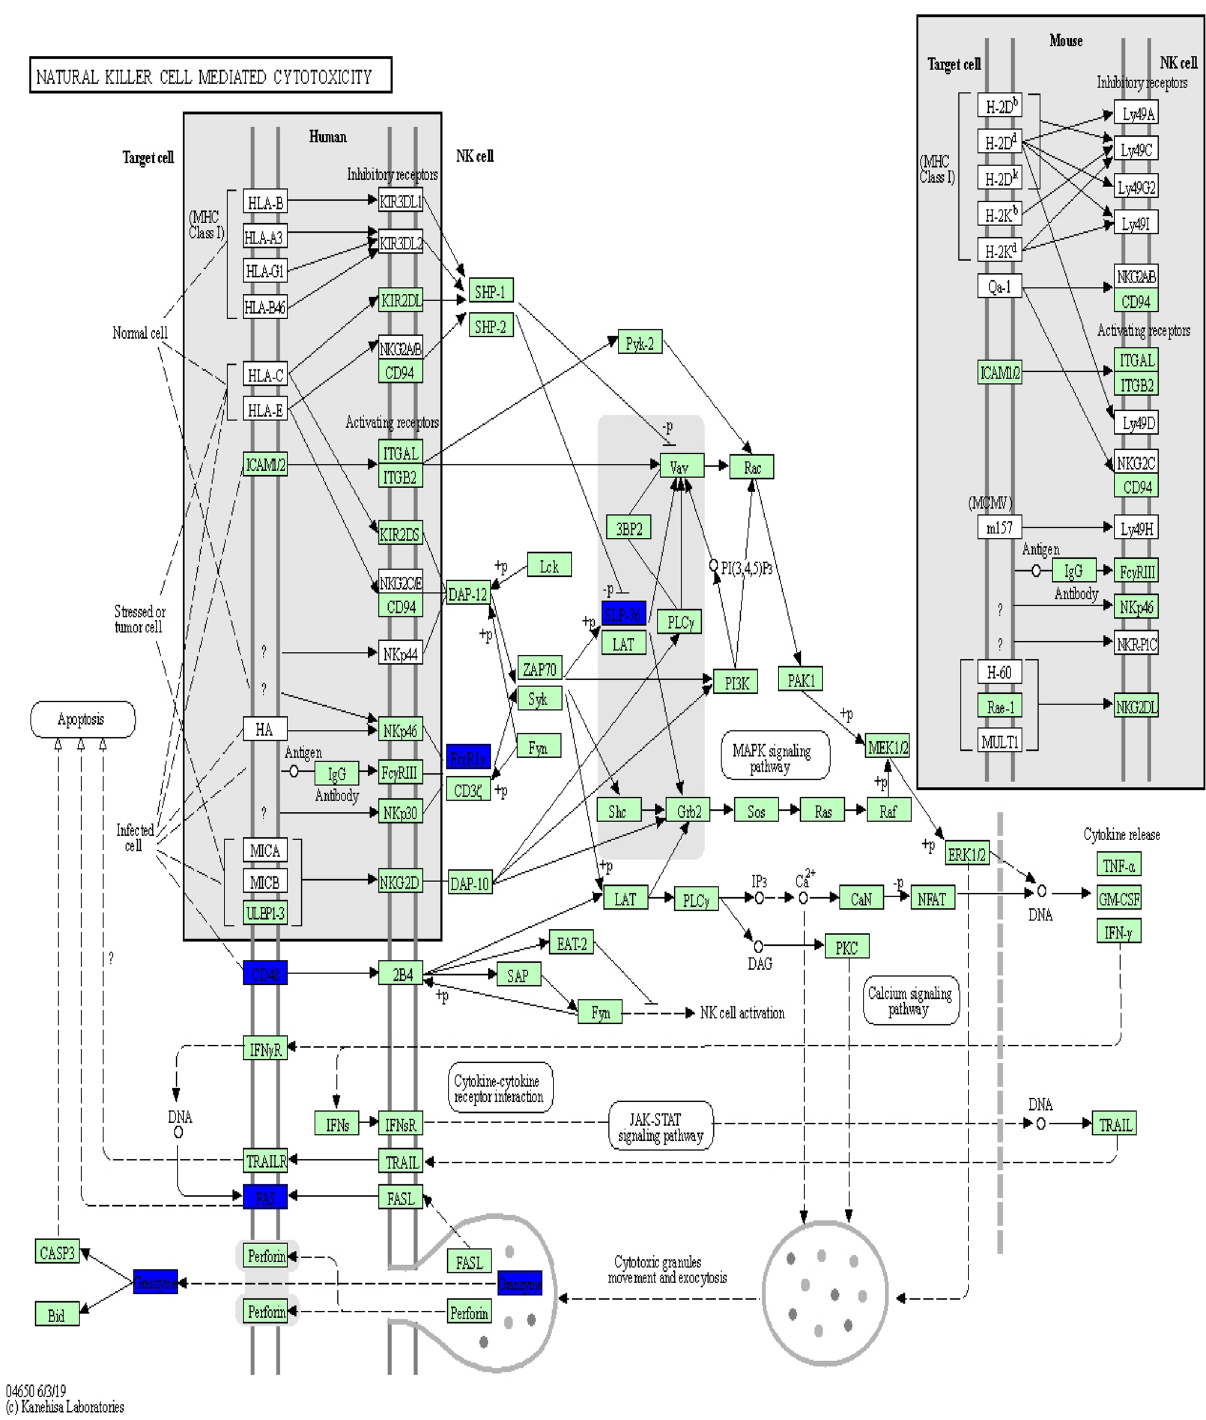
Figure 7. Differentially expressed genes involved in natural killer cell mediated cytotoxicity in the spleen of two sheep breeds. The blue-labelled genes were significantly down-regulated ( p < 0.05). The green-labelled genes were expressed in both sheep spleens. KEGG pathway annotation was conducted using the DAVID website (http://david .abcc.ncifc rf.gov/) and searching the KEGG